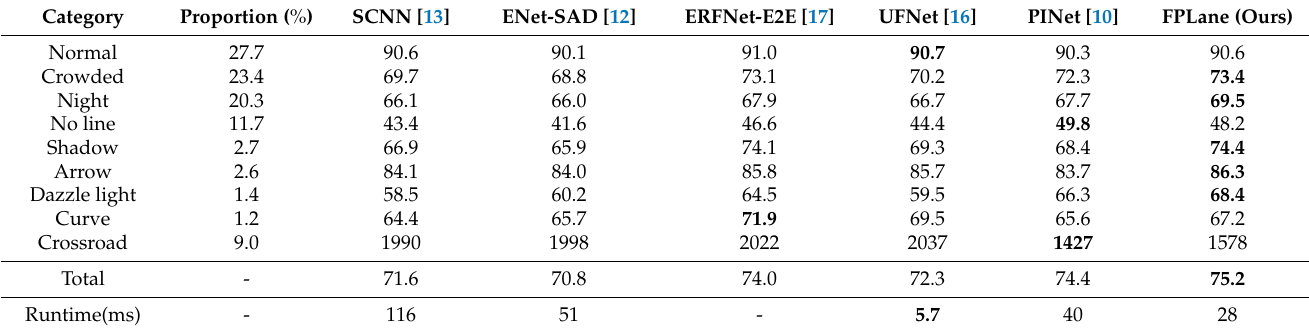
Figure 8. Visualized results of FPLane on CULane testing set. The second row is labels and the third row is predicted results of FPLane. Table 4. Evaluation results on CULane dataset. F1-score is evaluation metric of the dataset. For crossroad, only FP is shown.